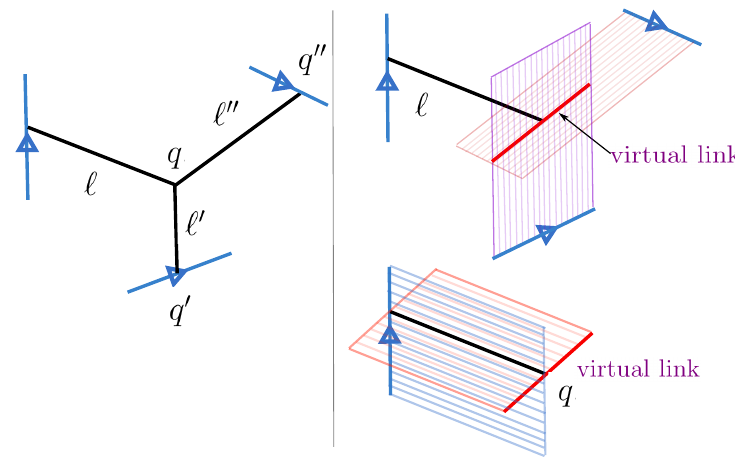
Figure 21 . Upper right: the construction of a virtual link (red) passing through the internal vertex q of a trivalent web. The virtual link is obtained as the intersection of two surfaces (called thicken- ings ) emanating from the link ends of the two legs ‘ 0 and ‘ 00 . Lower right: the segment ‘ in the web is the intersection of two thickenings, one emanating from the link end, the other from the virtual link.